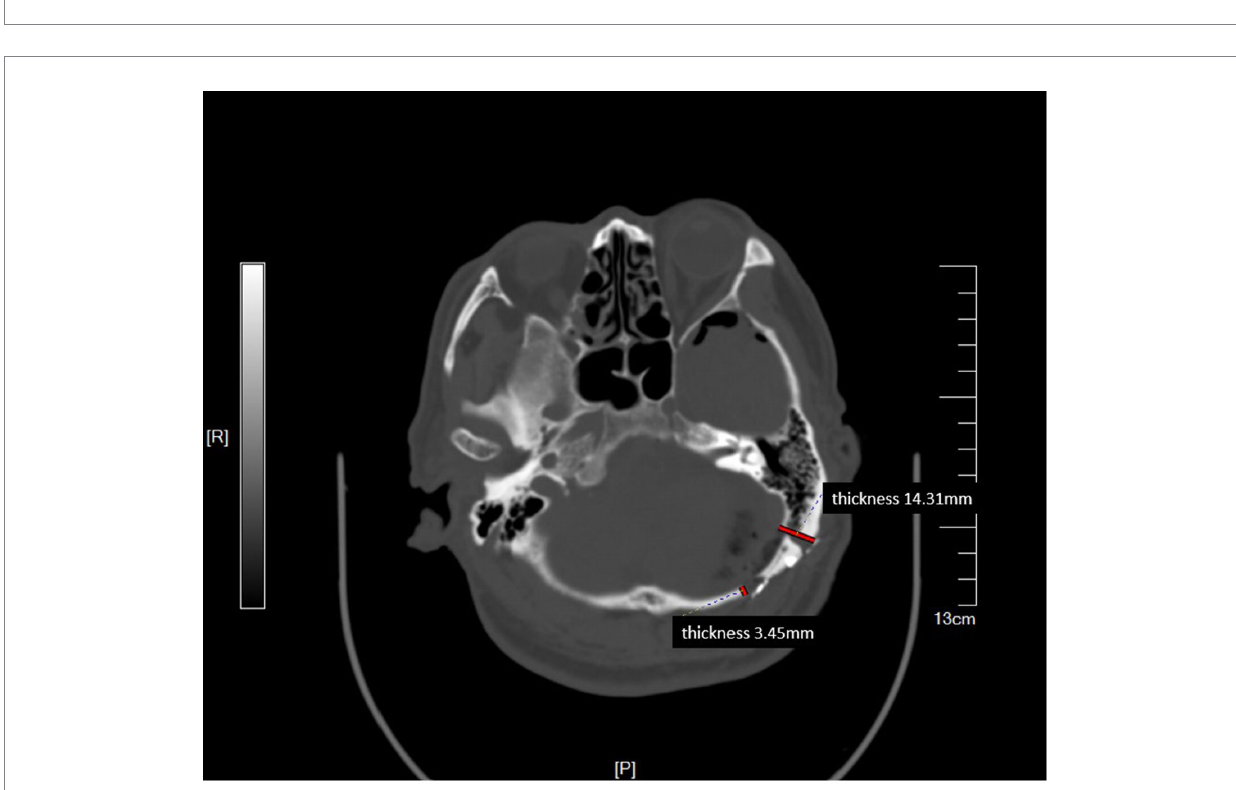
FIGURE 4 Postoperative CT showing the location of bone flap flush with the sigmoid sinus. The thickness of skull before (45) and behind the bone flap is shown in